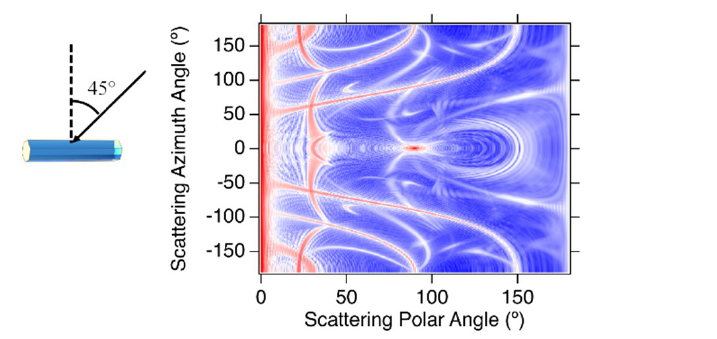
Figure 4. The two-dimensional phase function (P 11 ) of: (upper panel) horizontally oriented ice plates (i.e., the asymmetry axes of hexagonal plates are aligned vertically, but the particles are oriented in a rotationally random manner); and (lower panel) Parry oriented columns (i.e., the symmetry axes of hexagonal columns are aligned horizontally with two parallel prism side facets perpendicular to the vertical direction). The particle aspect ratio is a/L = 1000 μm/250 μm for a plate and a/L = 250 μm/1000 μm for a column (a and L are the semi-width and thickness, respectively) at wavelength λ = 0.532 µ m. The incident configuration is illustrated in the left diagram.